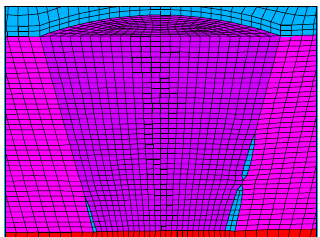
Figure 4. Crack reconstruction model under 18.8186 MPa load step.